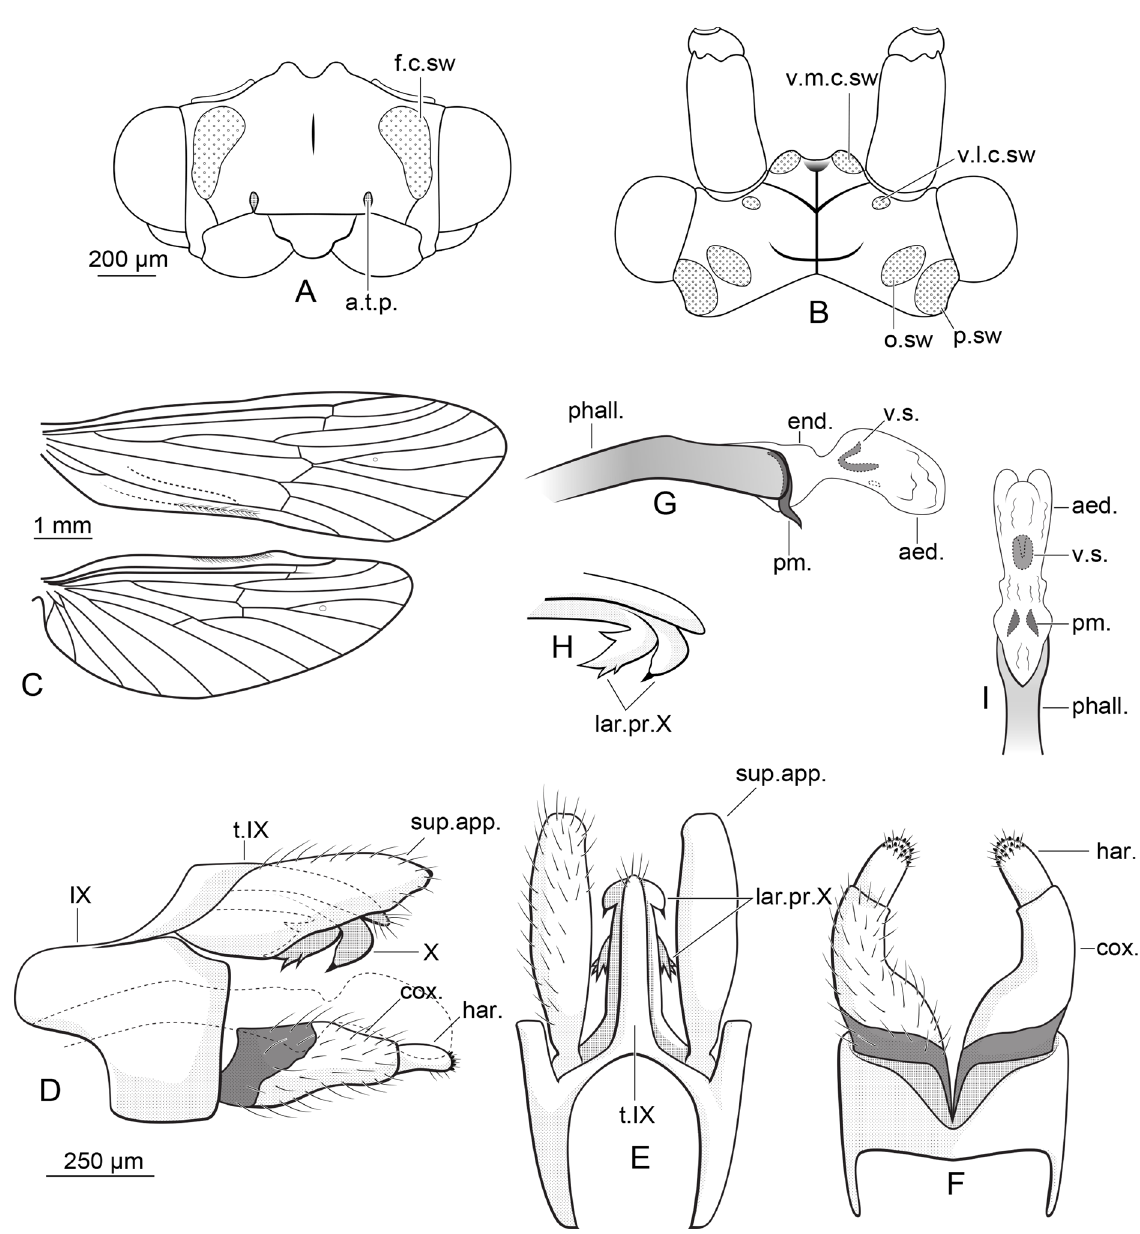
Fig. 3. Psilotreta brevispinosa sp. nov. A . Head, anterior view. B . Head, dorsal view. C . Wing veins. D . Male genitalia, left lateral view. E . Male genitalia, dorsal view. F . Male genitalia, ventral view. G . Phallus, left lateral view. H . Segment X, left lateral view. I . Phallus, ventral view, with basal half of phallotheca omitted. Scale bars: A–C = 200 µm; D = 1 mm; E–K = 250